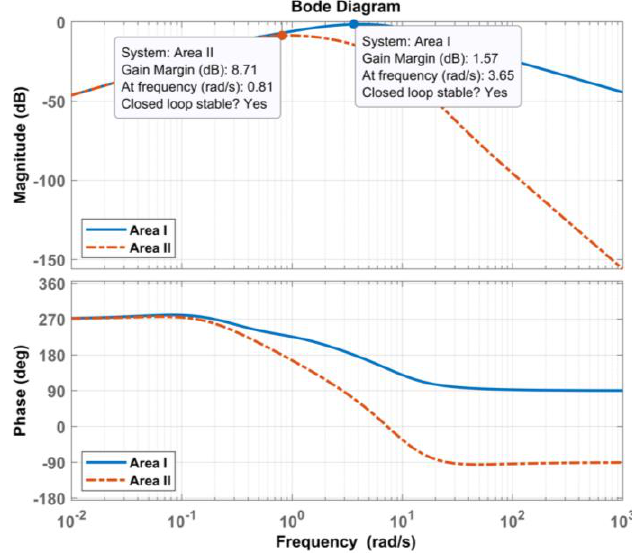
Figure 20. Bode analysis of frequency